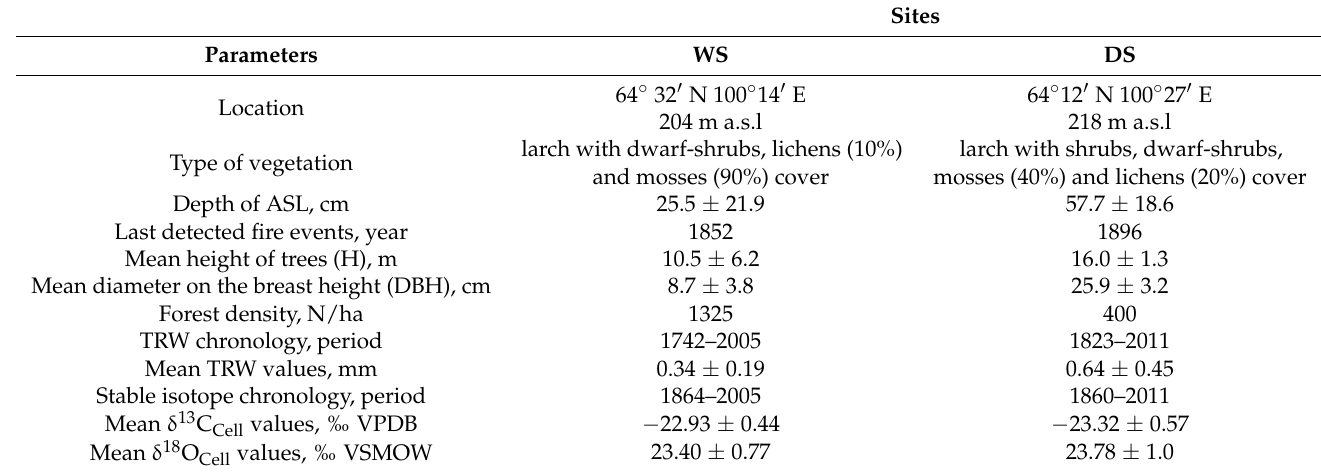
Table 1. Site characteristics (statistical values are given with standard